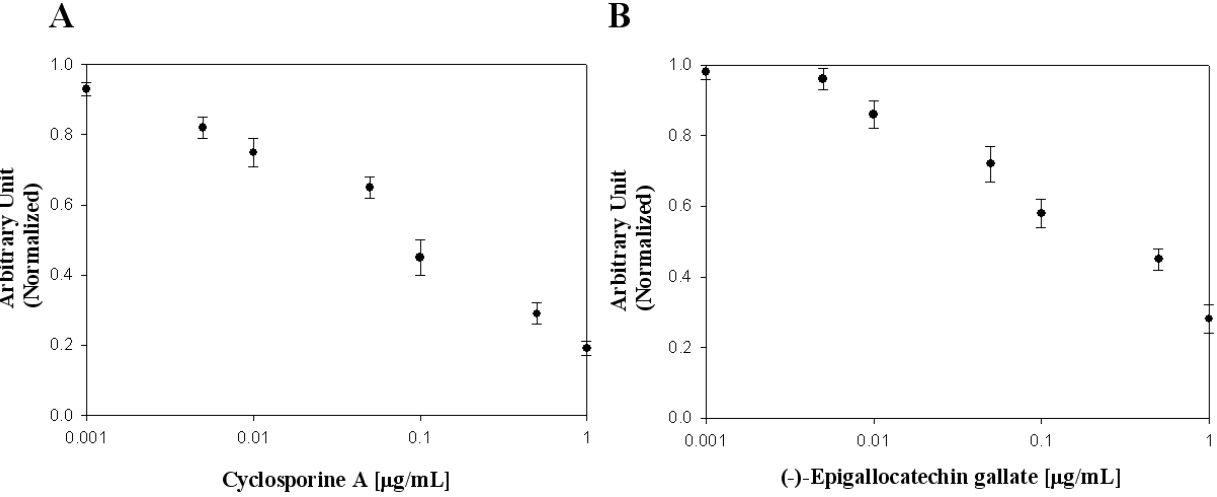
Figure 5. Inhibitory effect of (A) cyclosporin A and (B) ( − )-epigallocatechin gallate on viral protein